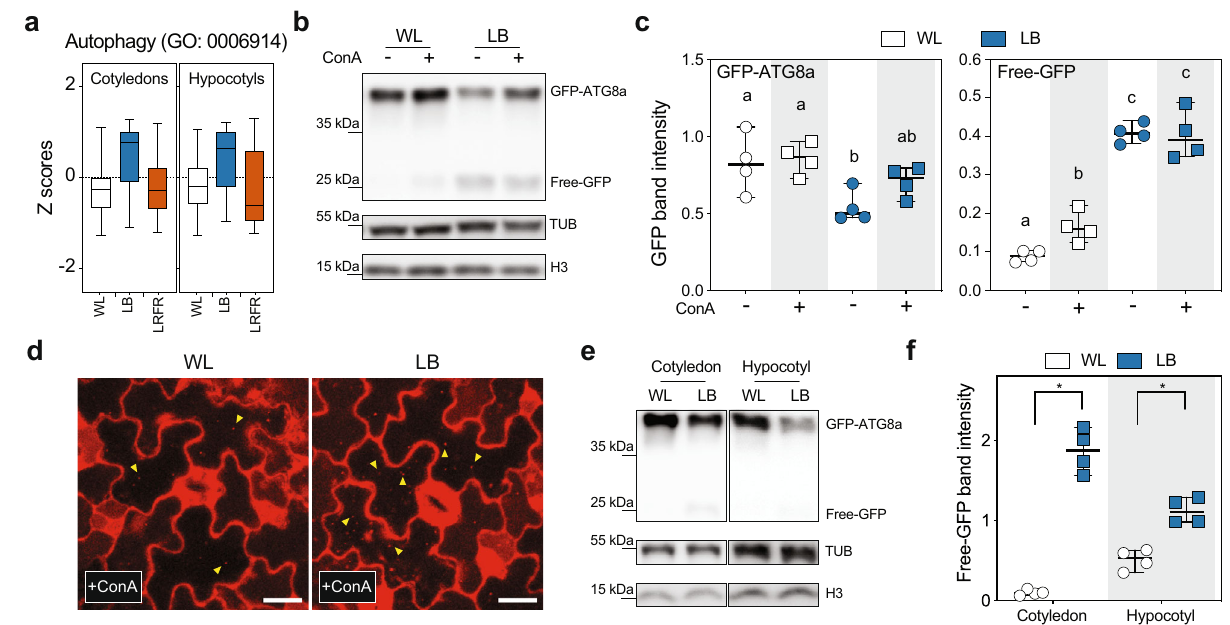
Fig. 7 | LB induces autophagy. a Distributions of Z-scores computed from replicates averages for genes listed in autophagy GO term in Col-0 seedlings. The horizontal bar represents the median; boxes extend from the 25th to the 75thpercentile,whiskersextendtoshowthe datarange.Thefulllistofgenes in the Autophagy GO term is given in Supplementary Data 10. b Representative image of autophagic fl ux assay using 35S:GFP-ATG8a (WT), seedlings were grown in the indicated light conditions with or without ConA (0.5 µ M). GFP- ATG8a and free GFP levels were detected in total protein extracts with an anti- GFPantibody. c Quanti fi cationofGFP-ATG8aandfree-GFPbandsinautophagic fl ux assays. Different letters indicate a signi fi cant difference ( P <0.05, two-way ANOVA with Tukey ’ s HSD test; the exact P values are available in the Source Data). d Representative image of cotyledon pavement cells expressing UBQ10:mCherry-ATG8e in the WT background either kept in WL or treated with